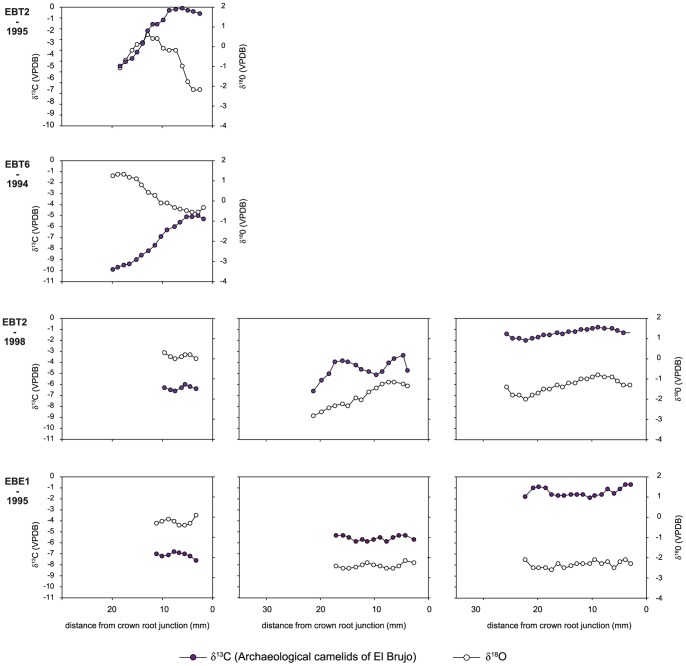
Intra-tooth isotopic composition of enamel structural carbonate of El Brujo camelids.Intra-tooth variations in δ13C and δ18O values (‰ VPDB) measured along the molar crowns of archaeological and modern highland domestic camelids and estimation of the contribution of C3 and C4 plants during crown growth. For each specimen, the left graph is for the M1 molar, the middle graph for the M2 molar and the right graph for the M3 molar. On each graph, the left axis refers to δ13Cenamel values and the right to δ18Oenamel values.